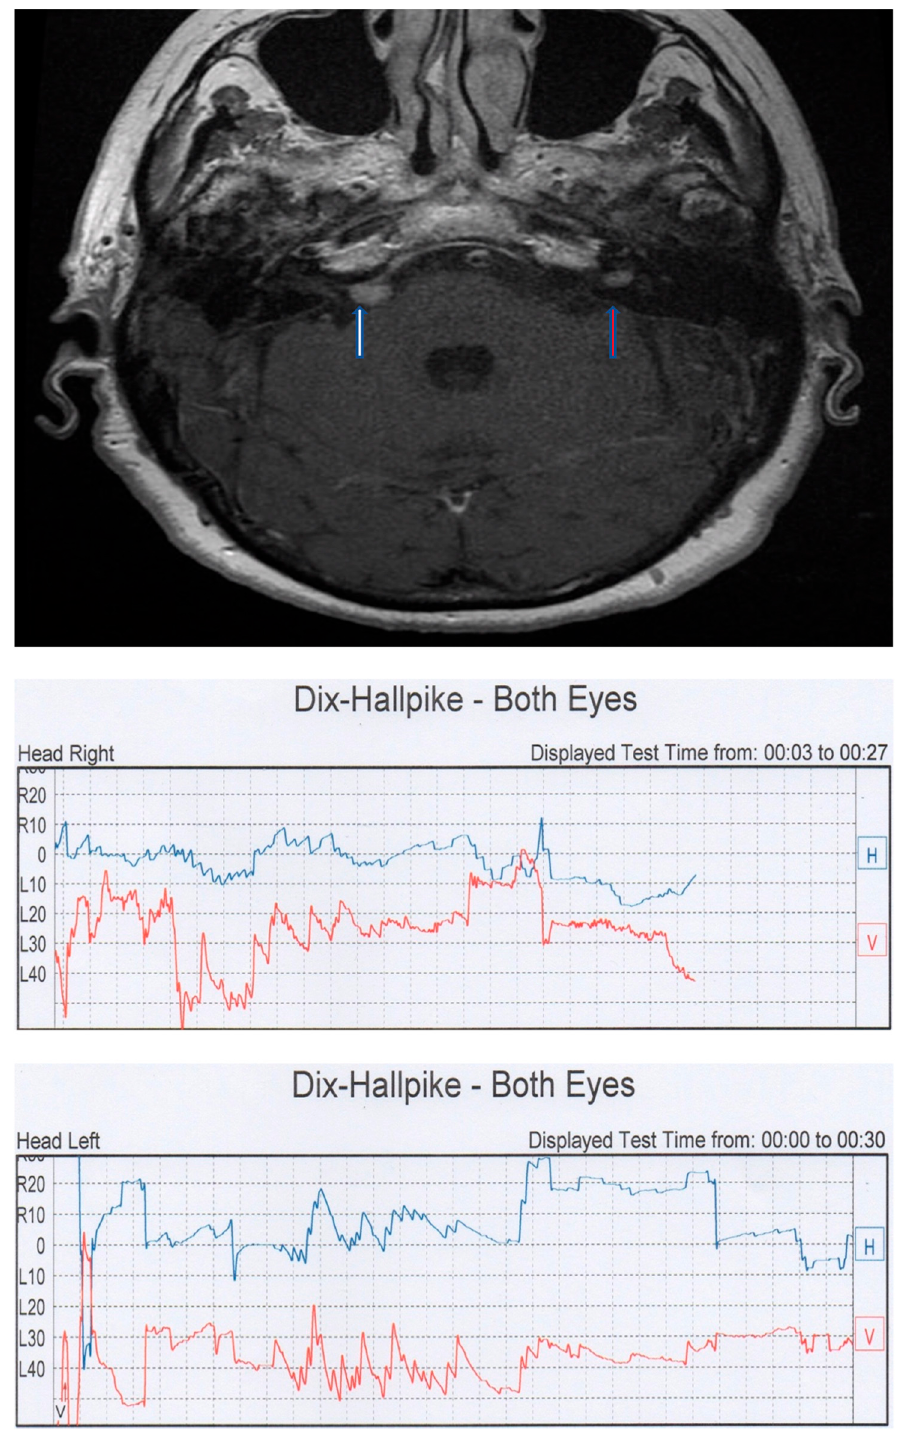
Figure 4. Case CT. ( Top ): right CPA meningioma (white arrow) and left intrameatal AN (red arrow) (courtesy of E. Zanoletti). ( Bottom ): videonystagmographic recording of the Dix–Hallpike test showing a bilateral classic PSC BPPV picture.